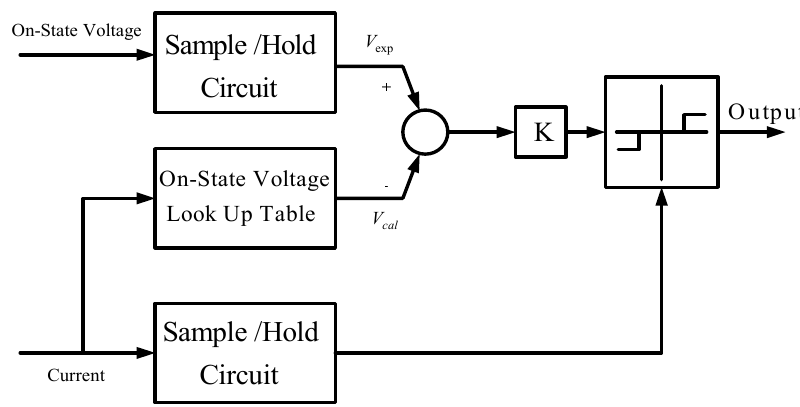
Figure 21. ON–state voltage monitoring [55].